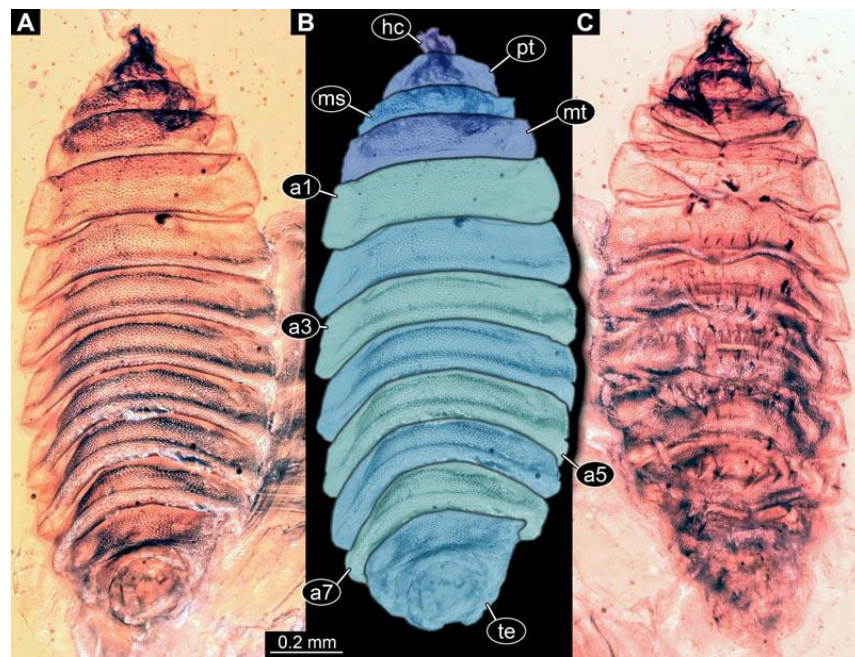
Figure 18. Fossil larva of morphotype 7, specimen PED 1295. ( A ). Dorsal view. ( B ). Colour-marked. ( C ). Ventral view. Abbreviations: a1 – a7 = abdomen units 1 – 7; hc = head capsule; ms = mesothorax; mt = metathorax; pt = prothorax; te = trunk end. (116) PED 1346: Specimen accessible in dorsal and ventral view (Figure 19). Bubbles conceal details on some areas of specimen. Surface structure apparent. Head capsule well preserved. Ventral spine-like setae well developed (Figure 19A). Dimensions: body length 1.92 mm, body width 1.13 mm, head capsule length 0.27 mm, head capsule width 0.19 mm.